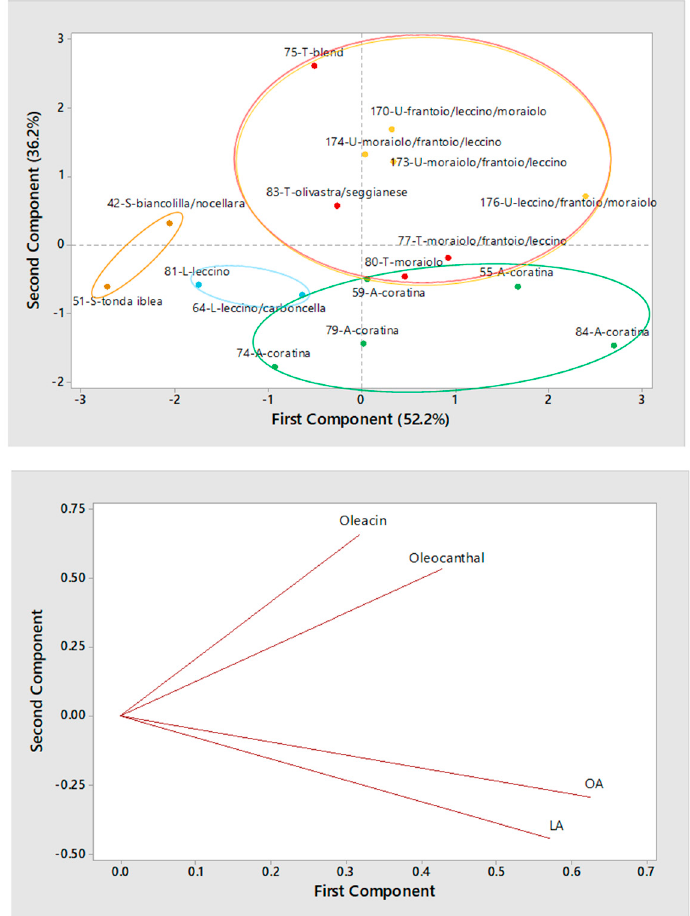
Figure 9. Score plot ( top panel ) and Loading plot ( bottom panel ) referred to the first two components provided by Principal Components Analysis (PCA) based on average normalized peak areas obtained for OA, LA, oleacin and oleocanthal (including the contribution of their carboxylic derivatives, if present) after the RPLC-ESI(-)-FTMS analysis of two replicated extracts for each of 17 Italian EVOOs produced during the 2017/2018 campaign using a two-phase decanter for horizontal centrifugation. Samples are labelled according to number (see Table 1), region (A = Apulia, L = Lazio, S = Sicily, T = Tuscany, U = Umbria) and cultivar.